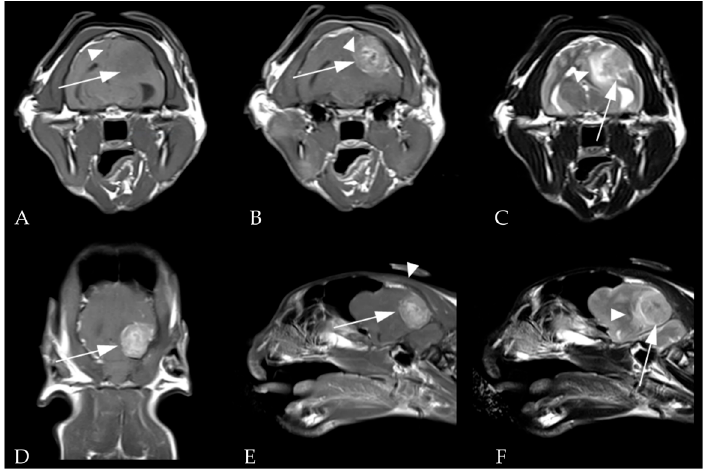
Figure 1. Preoperative magnetic resonance images (MRI) of the brain. ( A ) Transverse view of the brain in a T1-weighted window showing the neoplasm (arrow) with a homogenous hypointensity compared to gray matter. The cerebral midline is shifted (arrowhead). ( B ) Transverse view in a T1-weighted window after contrast enhancement revealing a dural tail sign (arrowhead) dorsal to the mass (arrow). Transverse ( C ) and sagittal planes ( F ) in a T2-weighted window showing edematous changes (arrowhead) around the tumor (arrow). Mass (arrow) is homogenously hyperintense in the dorsal ( D ) and sagittal views ( E ) in a contrast enhanced T1-window.